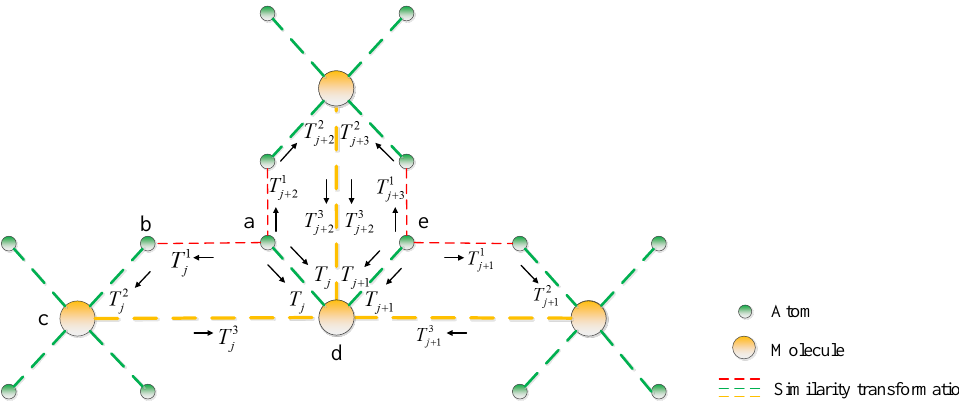
Figure 5. An illustration of the hybrid optimization. A similarity transformation between atom a and molecule d can be represented by T j or by T 1 transformation relationship in two directions. The introduction of the closed-loop constraint associates multiple similarity transformations and incorporates them into the global